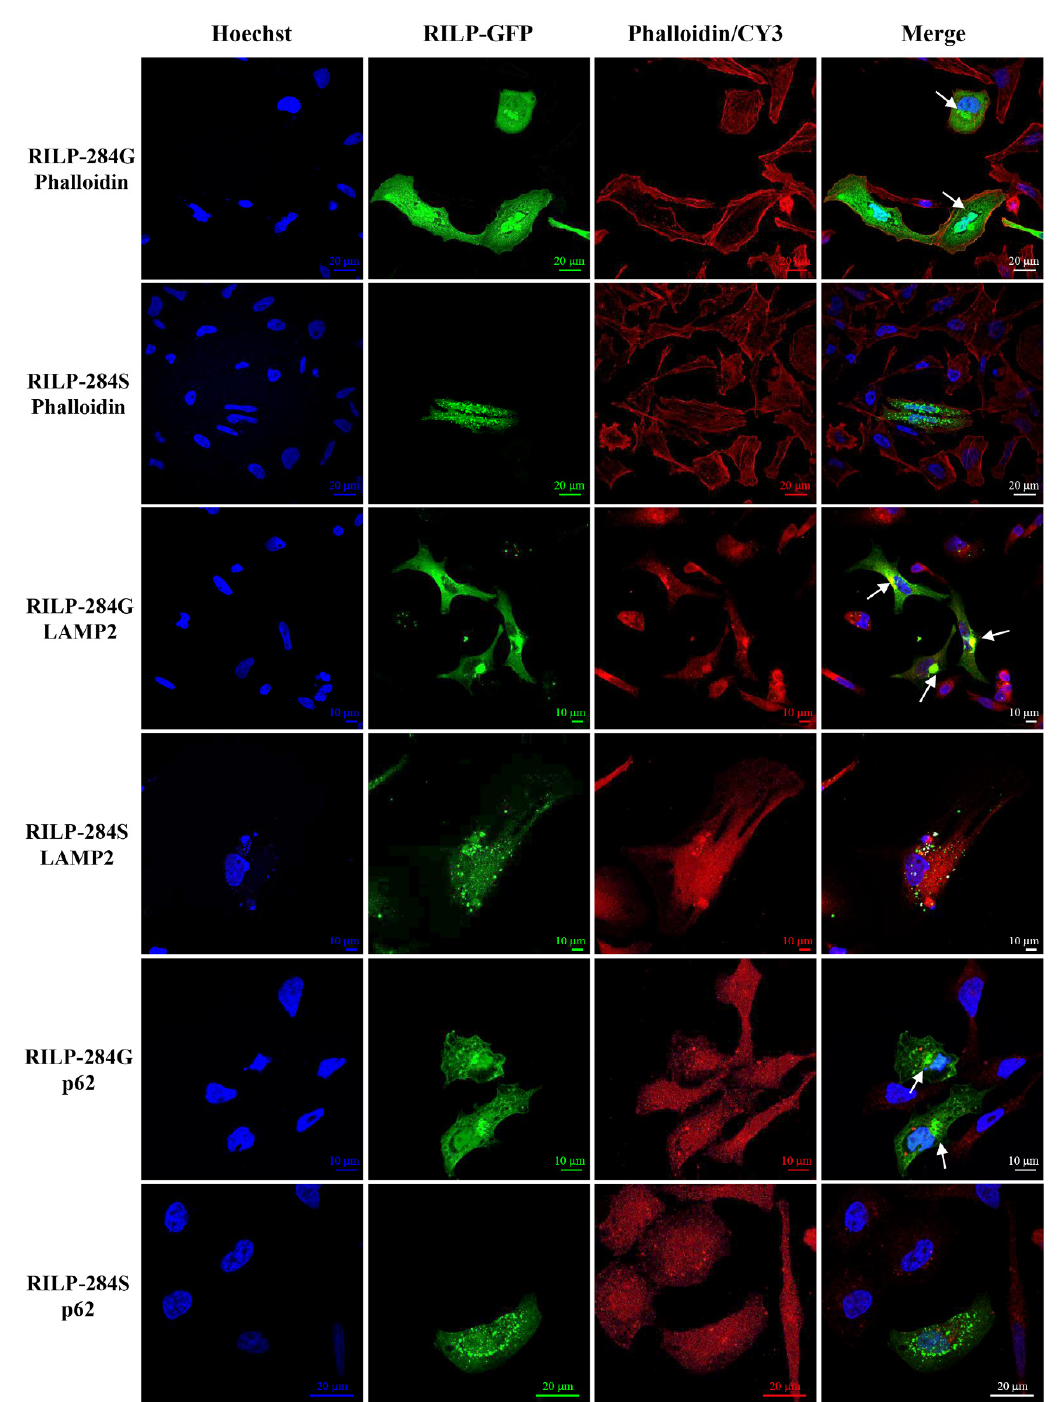
Figure 10. Immuno-localization of the RILP wt (RILP-284G-GFP) and mutant (RILP-284S-GFP) proteins in the HeLa cells wt and mutant. RILP proteins were fused to the green fluorescent protein (GFP), and LAMP2 and p62 proteins were stained using anti-LAMP2/CY3 and anti-p62/CY3. F-actin fibres were stained with rhodamin phalloidin and nuclei were stained with Hoechst. Slides were visualized with a Nikon Confocal Microscope A1R at 60× magnification. The localization of the RILP wt is indicated by intense green spots localized near the nucleus. The LAMP2/CY3 reaction was quite superimposable to that of RILP. The RILP